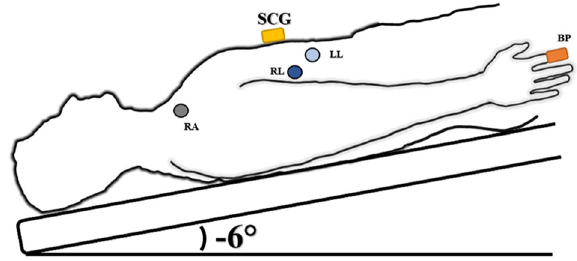
Fig. 1 HDT schematic of sensor placement. SCG (yellow rectangle) placed on the xiphoid process. Blood pressure measured at the fi nger (orange rectangle). ECG Lead II shown RA lead (gray circle) on right clavicle, RL lead (dark blue circle) on lower right rib cage and LL (light blue circle) on lower left rib